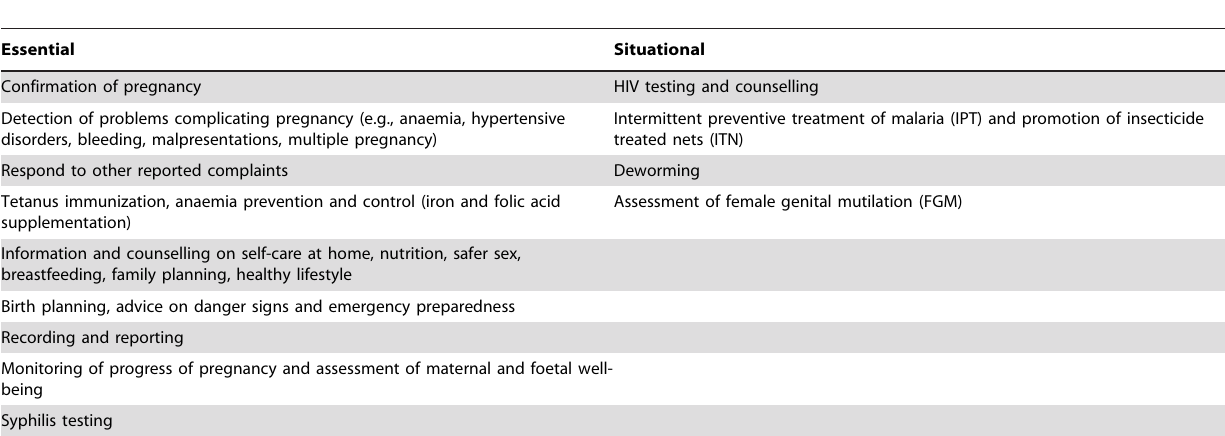
Table 1. WHO-recommended procedures for ANC